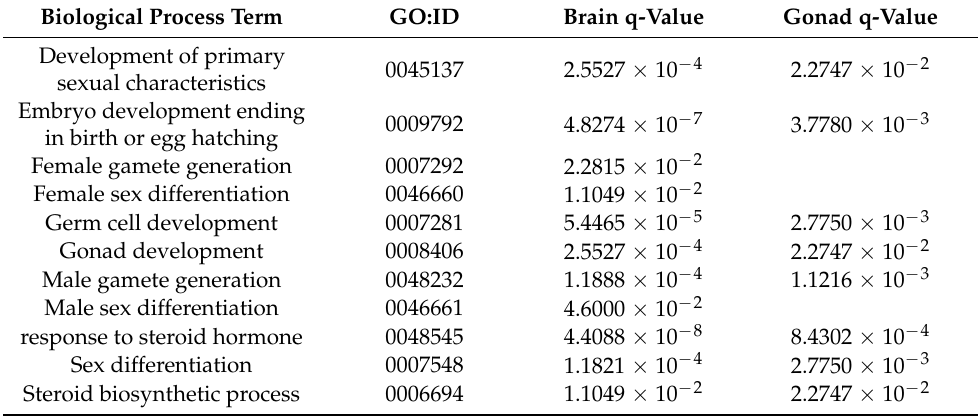
Table 3. Significantly enriched biological processes in brain and gonadal tissue of loggerheads. Selected biological process Gene Ontology (GO) terms with significant enrichment between logger- heads reared below and above 29 ◦ C are displayed. Q-value refers to p -values adjusted for the false discovery rate